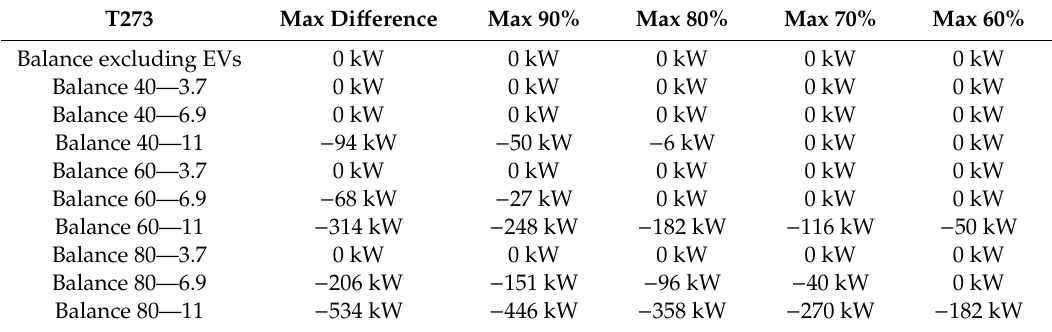
Table 13. Replacement of electric heating by district heating for transformer T273—constant charging.